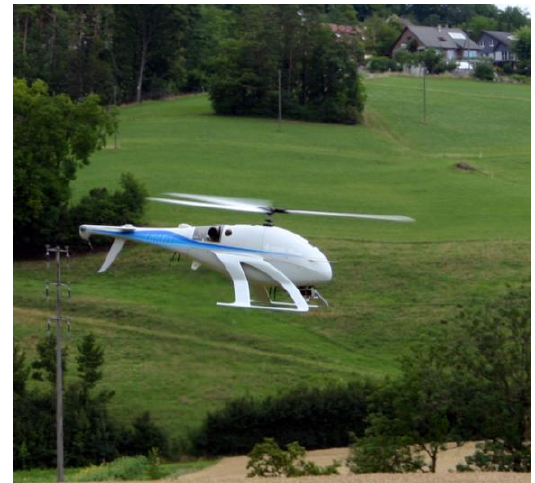
Fig. 12 First flight of SAR sensor package using the